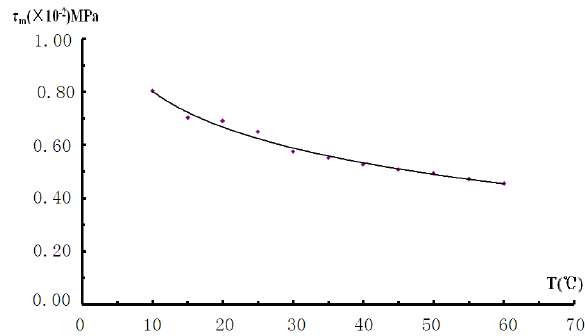
τ –T relationship curve of strength reduction material. Figure 5. Typical τ – T relationship curve of strength reduction material. Figure 5. Typical